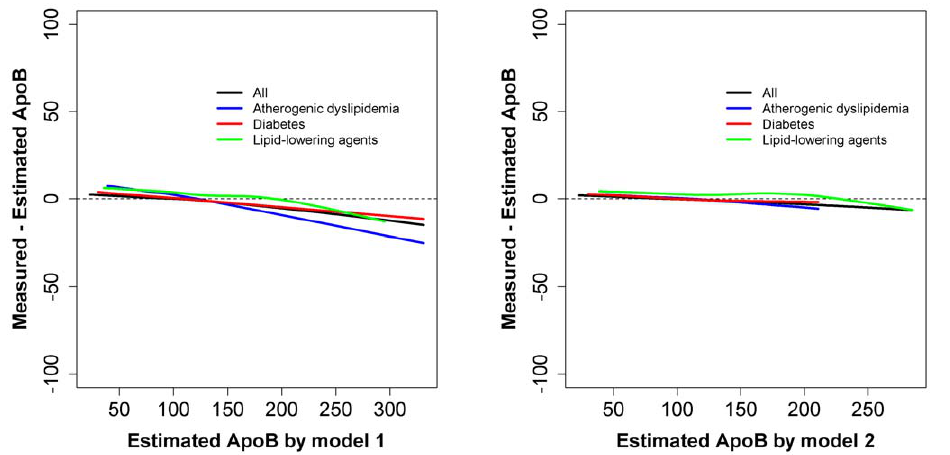
Figure 3. Comparison of the two apoB equations for subgroups. All subjects (black), those with atherogenic dyslipidemia (blue), diabetes (red), or those taking lipid-lowering agents (green) ( A , model 1 and B , model 2). The lines are LOWESS curves of errors (=measured - estimated apoB); the closer the curve to 0, the better the fit.